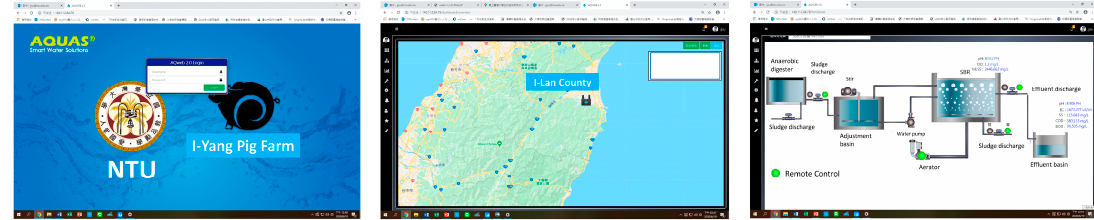
Figure 7. The appearance of the home page (left), location map (middle), and operaton flowchart (right) of AQWEB software login page for this study.